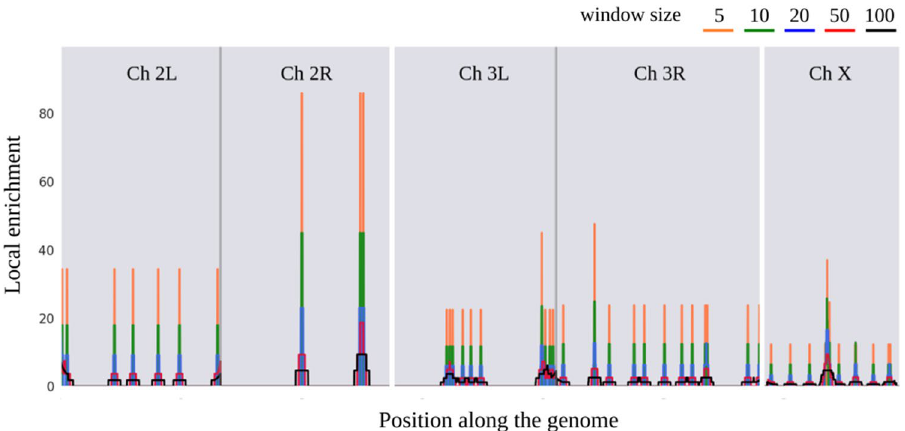
Figure 2. Functional enrichment map of the GO term "Golgi membrane" (GO:0000139) in the genome of D. melanogaster. There are 50 Drosophila genes annotated with this GO term that belongs to the Cellular Component ontology. The chromosomal position is represented in the x axis and the corresponding local enrichment at each position is shown in the y axis. Each light gray block corresponds to a chromosome (only chromosomes 2, 3 and X are shown) and the vertical dark gray lines mark the position of the centromeres, which divide the chromosome 2 into arms 2L and 2R and chromosome 3 into arms 3L and 3R. The enrichment found using different windows is shown with the colors indicated in the